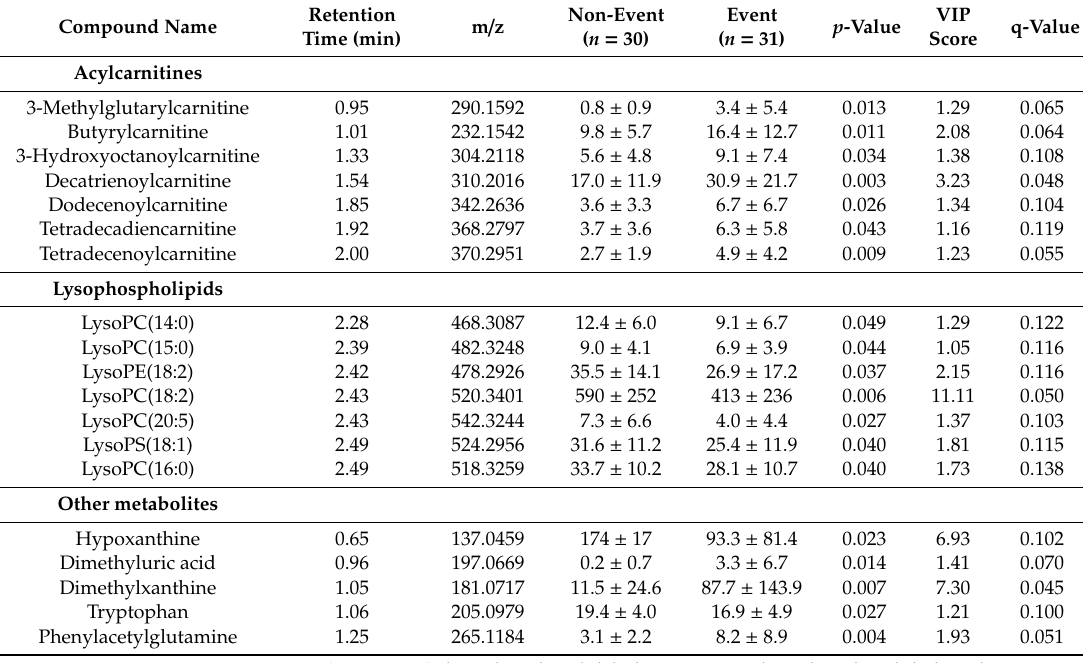
Table 2. Statistical analysis of the metabolites di ff erently abundant in event versus non-event groups (VIP score of > 1.0 and p value <